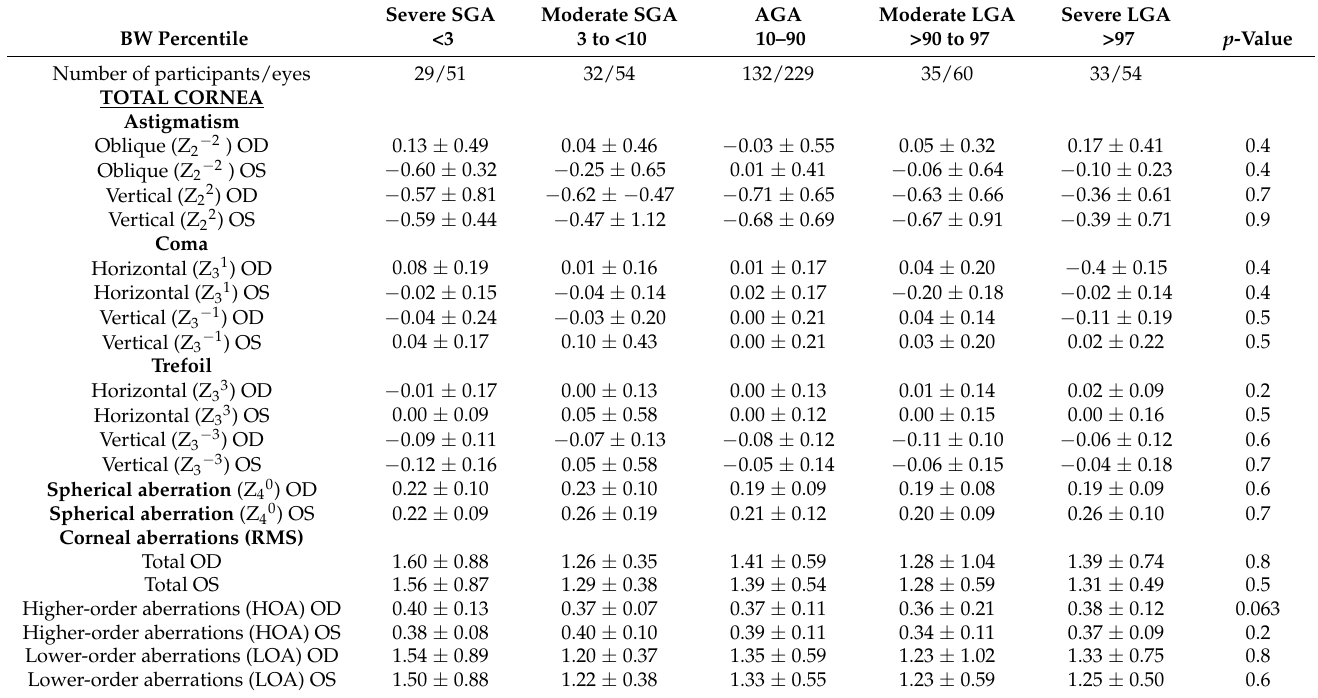
Table 2. Total corneal aberration parameters of the study sample ( n = 261) grouped according to birth weight percentile.